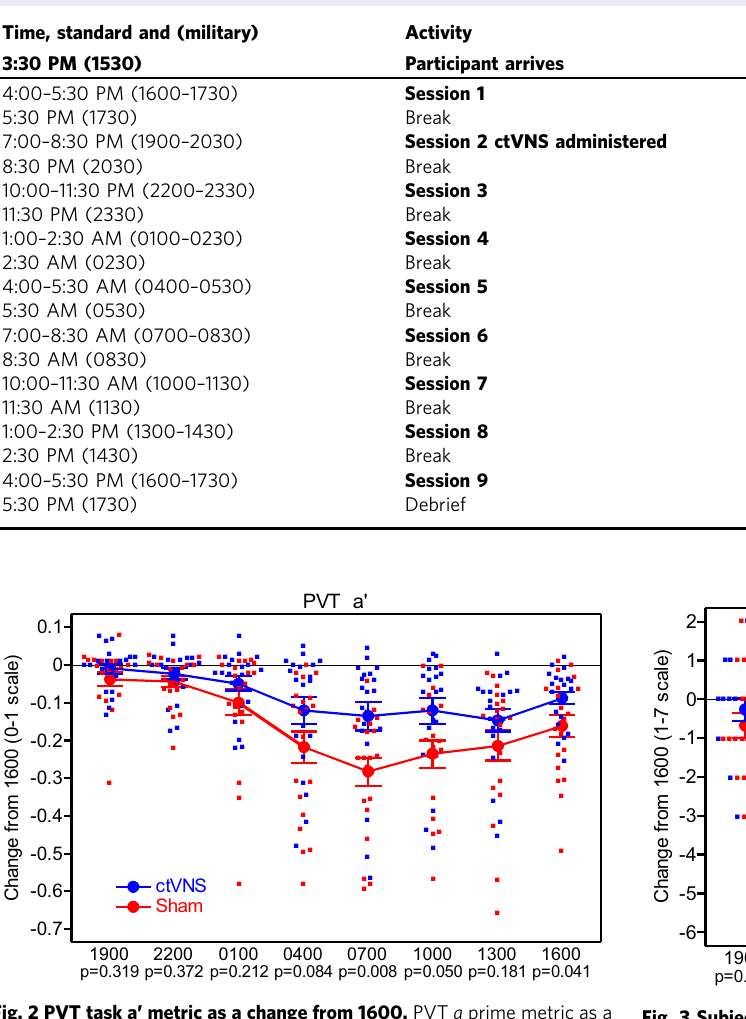
Fig. 3 Subjective mood rating of Fatigued/Energized scale as a change from 1600. Subjective mood rating of fatigued versus energized as a change from 1600 with error bars that are mean + / − SE.